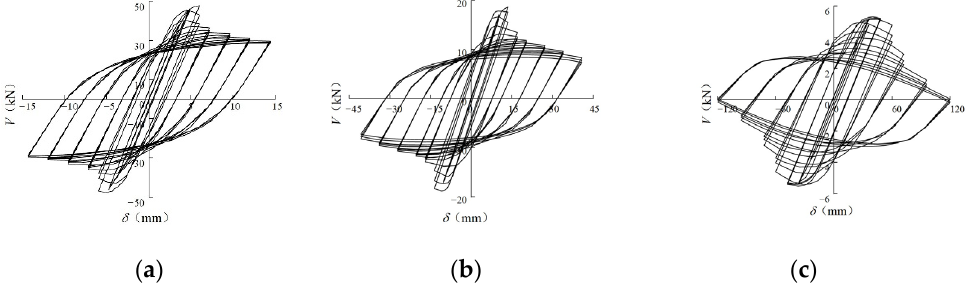
Figure 8. Hysteresis curves. ( a ) Hysteresis curves of C4-BC-L15-70-02; ( b ) Hysteresis curves of C3-BC-L30-60-03; ( c ) Hysteresis curves of C1-BC-L70-40-02.